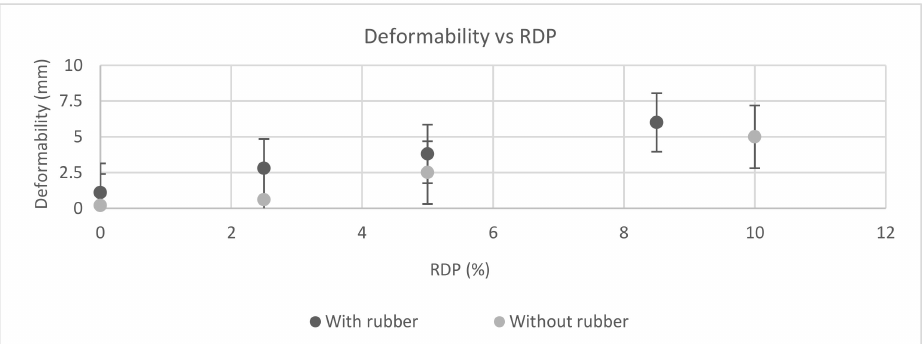
Figure 4. Transverse deformation according to EN 12004 for two tile adhesives, with and without recycle rubber incorporation, as a function RDP